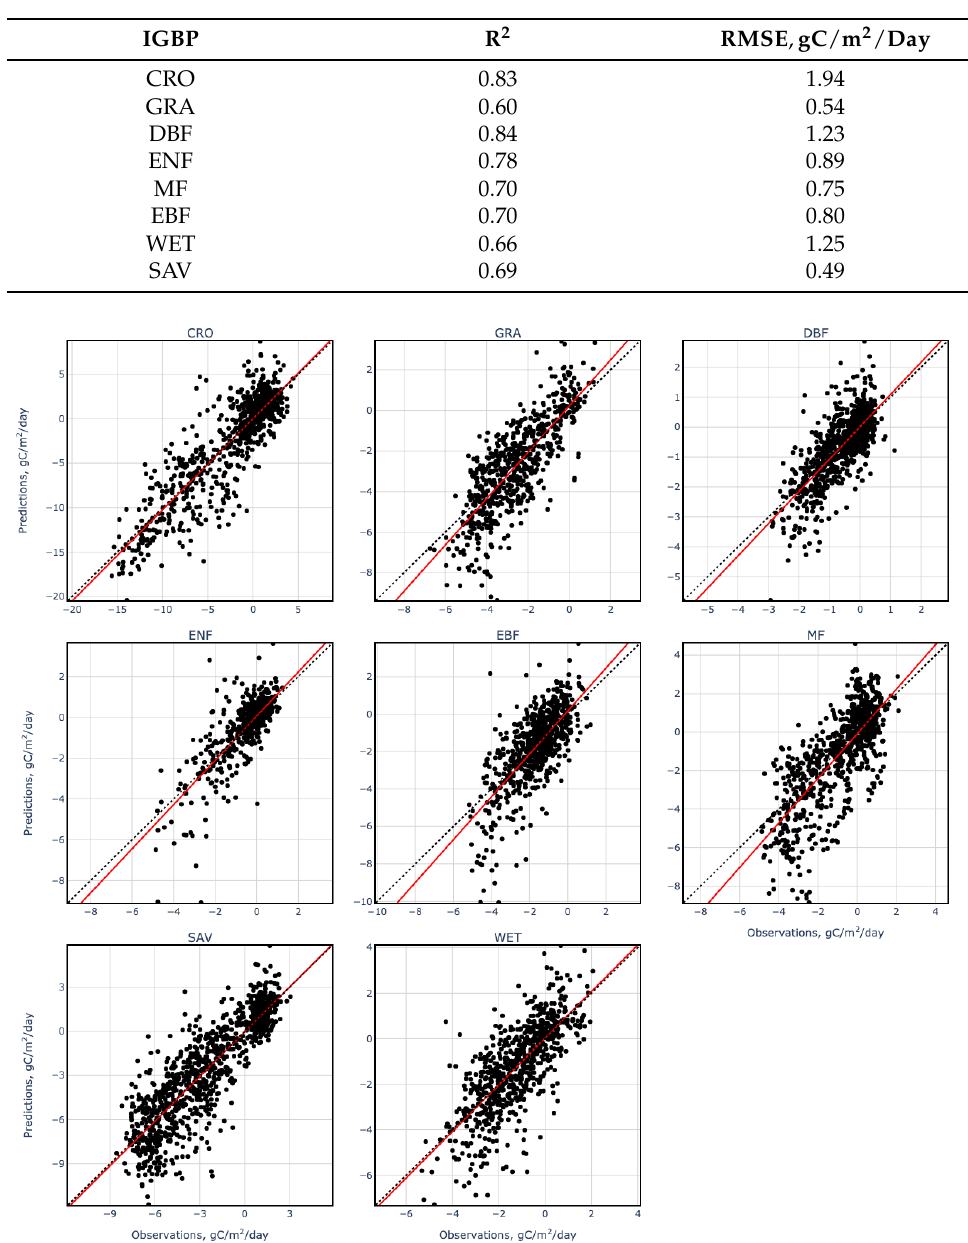
Figure 4. Scatterplots of observed NEE vs. predicted NEE based on remote sensing and meteorolog- ical features models per each land cover: cropland (CRO); grassland (GRA); evergreen needleleaf forest (ENF); deciduous broadleaf forest (DBF); evergreen broadleaf forest (EBF); mixed forest (MF); wetland (WET); savanna